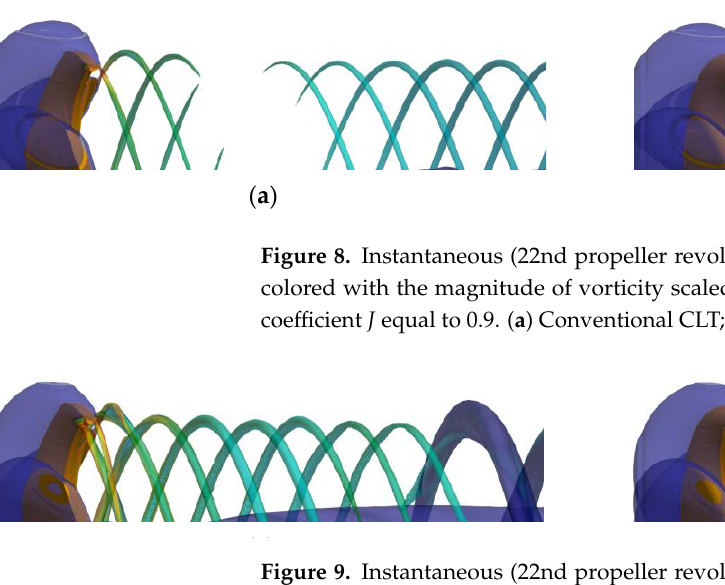
Figure 9. Instantaneous (22nd propeller revolution) isosurface of the pressure coefficient ( − C PN ) colored with the magnitude of vorticity scaled by U inf /D . Details at tip for − C PN = 0.2. Advance coefficient equal to 0.6. ( a ) Conventional CLT; ( b ) New generation